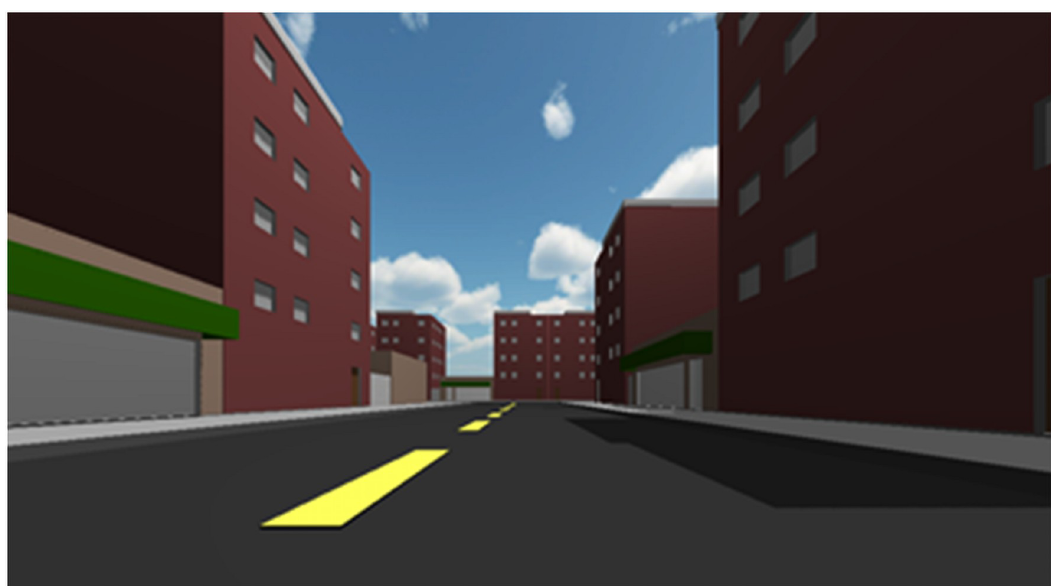
Fig 1. A view of the virtual reality environment displayed in the Oculus Rift. For the 0.1 Hz scene translation condition, the street and buildings would translate forward and backward to give the viewer the illusion of motion.